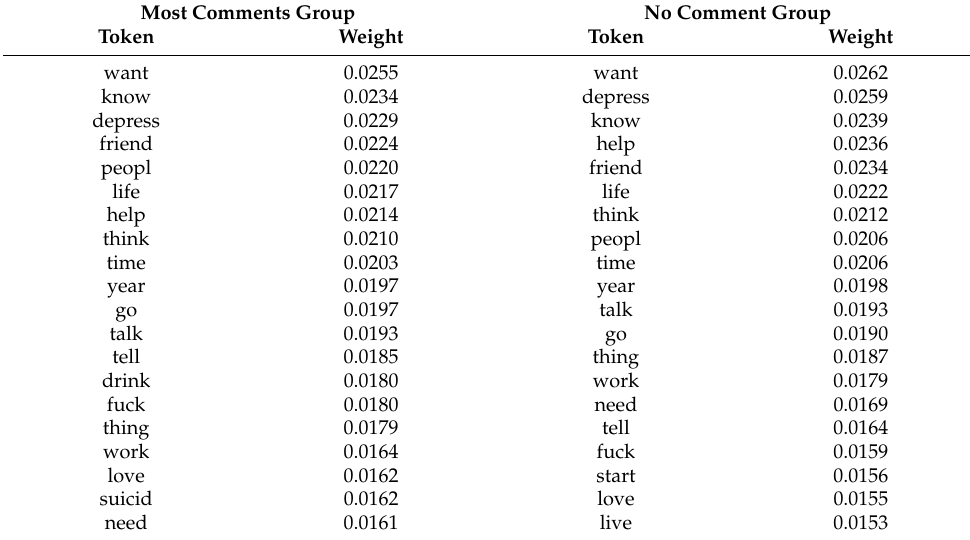
Table 5. Top 20 tokens with highest TF-IDF weight in “most comment group” and “no com- ments